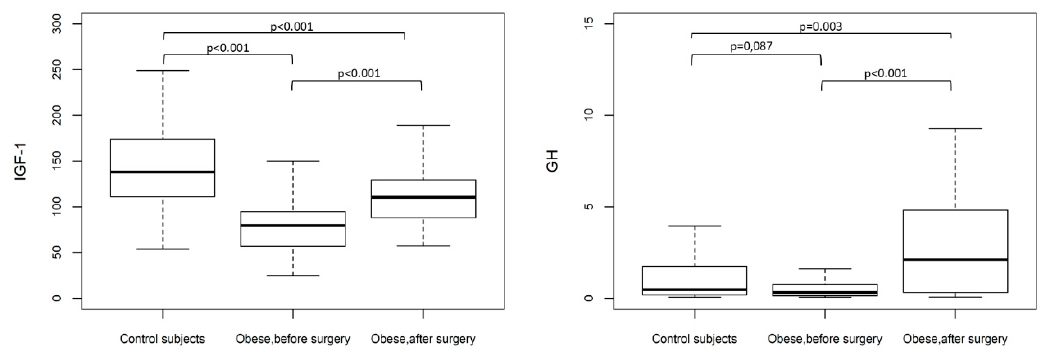
Figure 1. Insulin-like growth factor 1 (IGF-1) and growth hormone (GH) values (Median (IR)) in control subjects and obese patient before and twelve months after bariatric surgery.